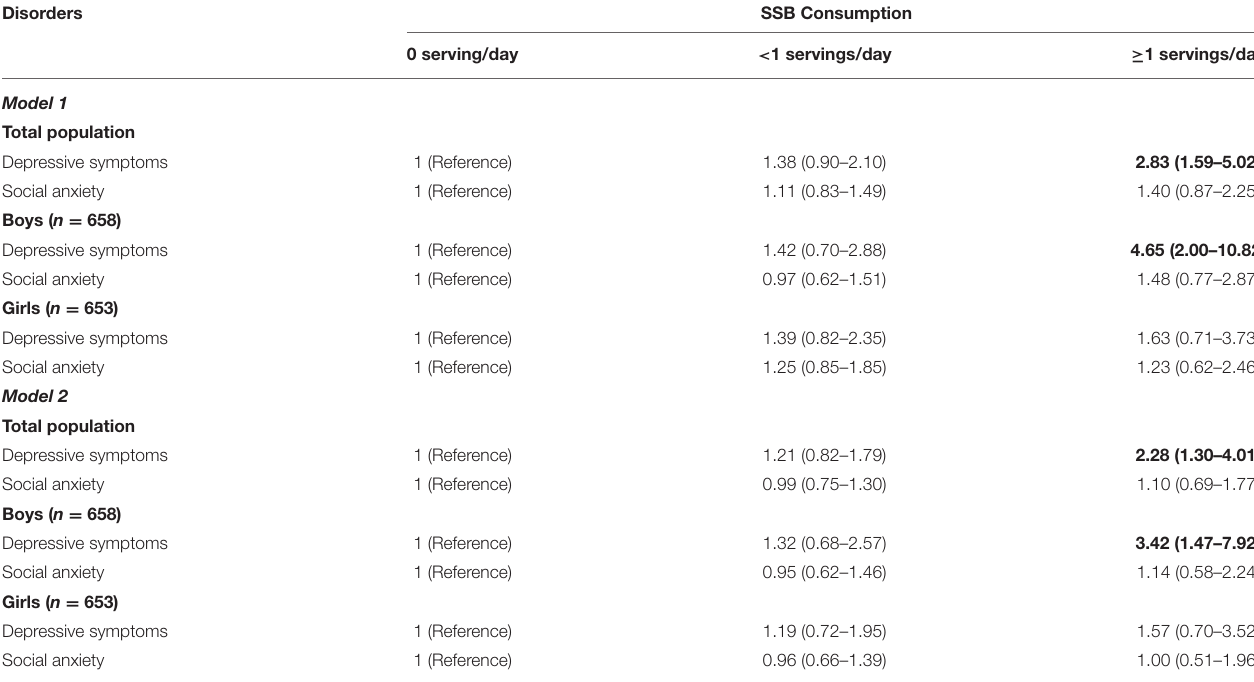
TABLE 2 | Multivariate odds ratios (ORs) and 95% confidence intervals (CIs) of SSB consumption for depressive and social anxiety symptoms.